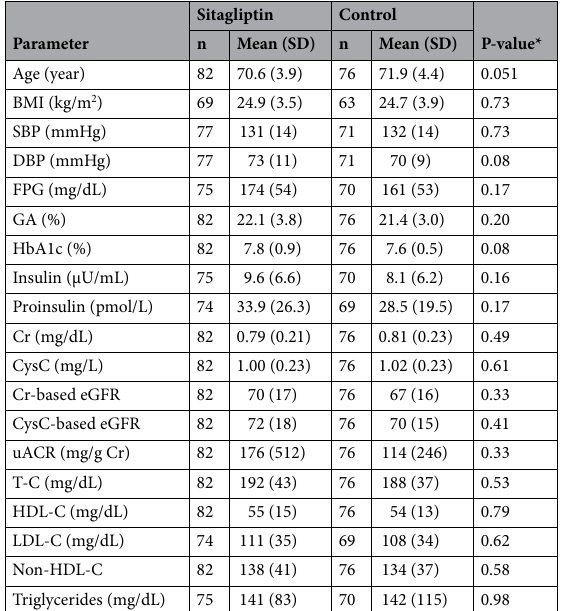
Table 1. Physical and laboratory measurements at baseline. *Between-group differences based on unpaired t-test. BMI body mass index, Cr creatinine, CysC cystatin C, DBP diastolic blood pressure, eGFR estimated